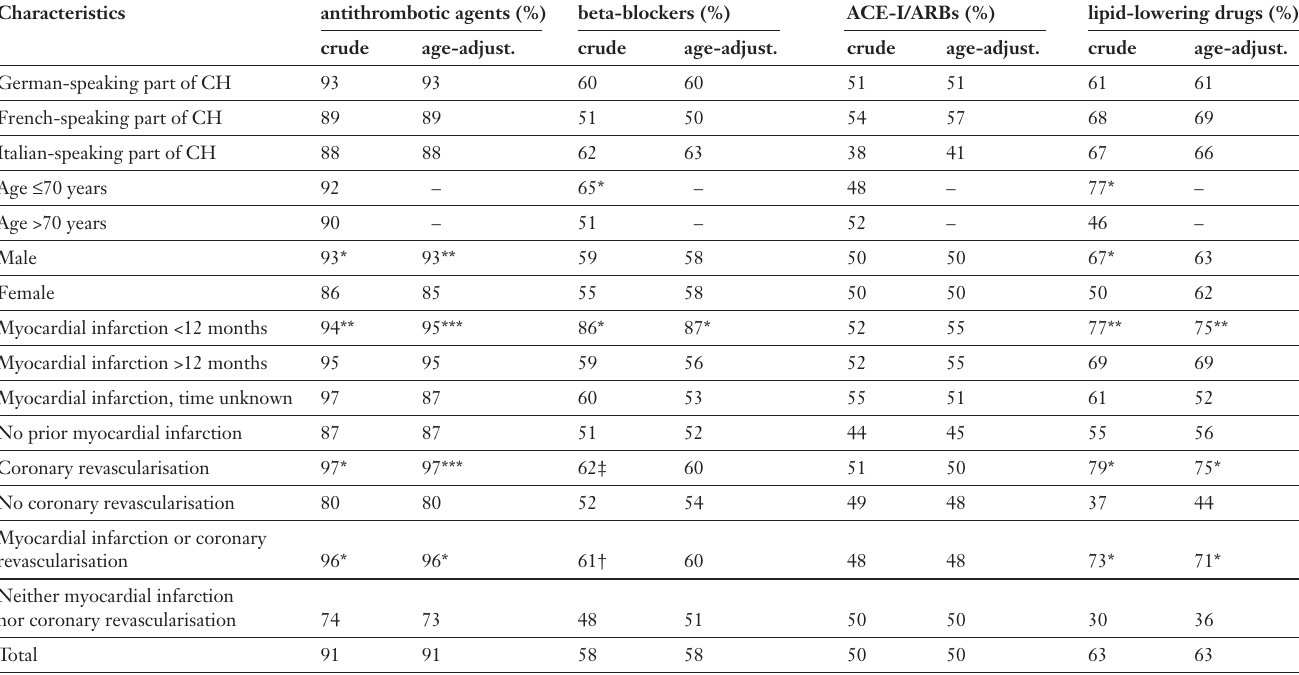
Unadjusted and age-adjusted prescription rates of cardiovascular drugs among outpatients with coronary artery disease according to different characteristics, Switzerland 2000/2001.